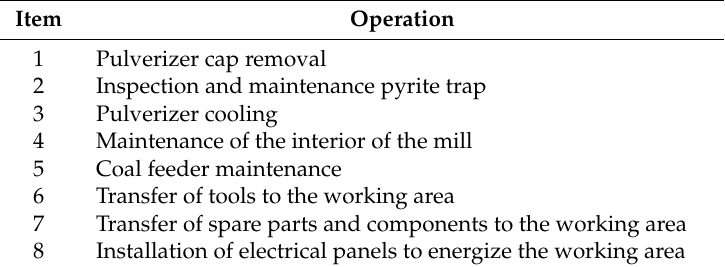
Table 6. Operations performed on the